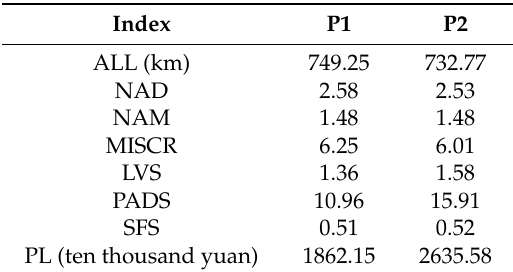
Table 4. System risk in recovery